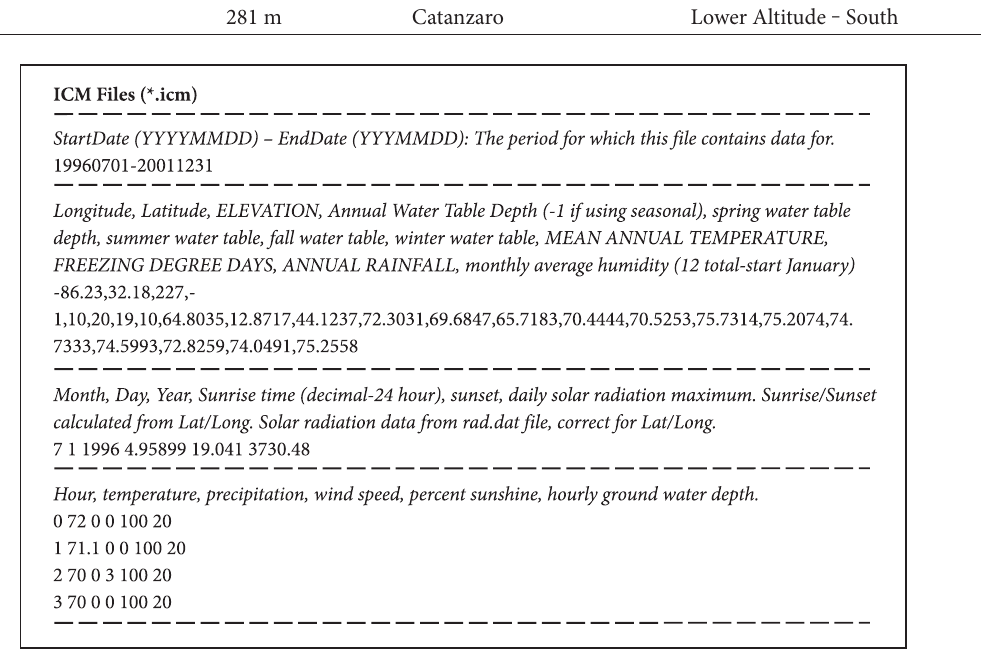
fig. 2. Layout of data entered into the